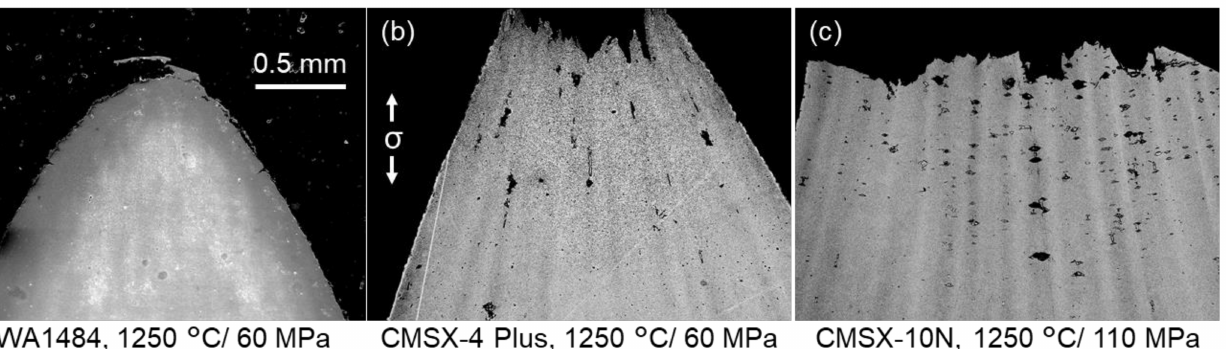
Figure 14. Necking and voids of PWA1484 tested at 1250 ◦ C/60 MPa ( a ), CMSX-4 Plus tested at 1250 ◦ C/60 MPa ( b ), and CMSX-10N tested at 1250 ◦ C/110 MPa ( c